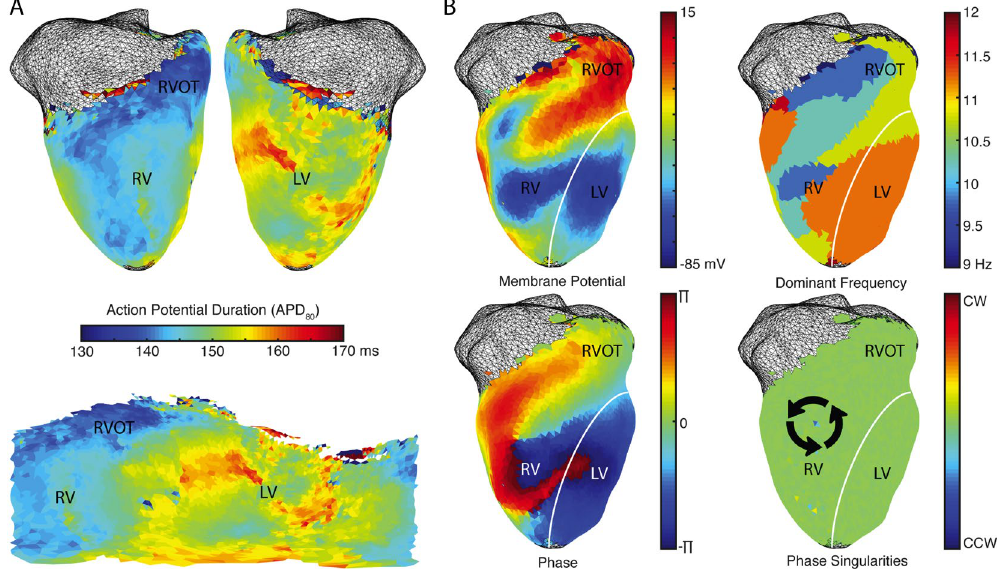
Figure 6. Repolarization and arrhythmia analysis in representative rabbit data. ( A ) Action potential duration can be calculated using projected data and unwrapped into a Mercator 2D representation. ( B ) Arrhythmias like ventricular fibrillation can be analyzed using calculations of dominant frequency, phase, and phase